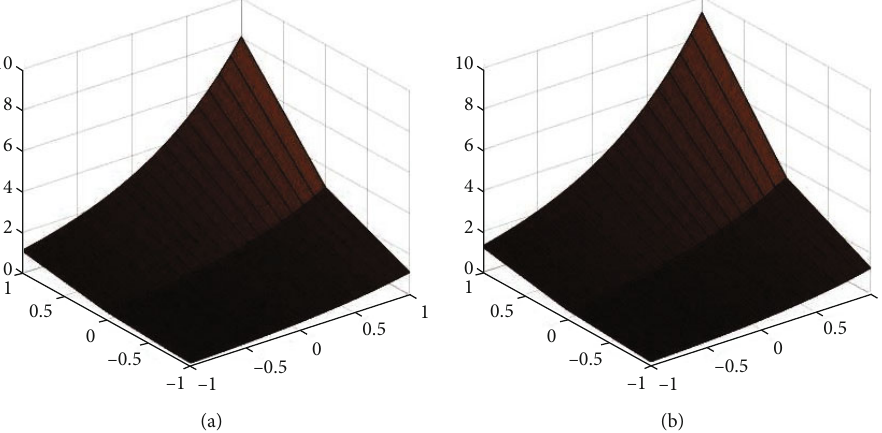
Figure 11: The graph of di ff erent approximate solution of Ψ ð χ , φ , η Þ at ϒ = (a) 0 : 8 and (b) 0 : 6 of example 2.